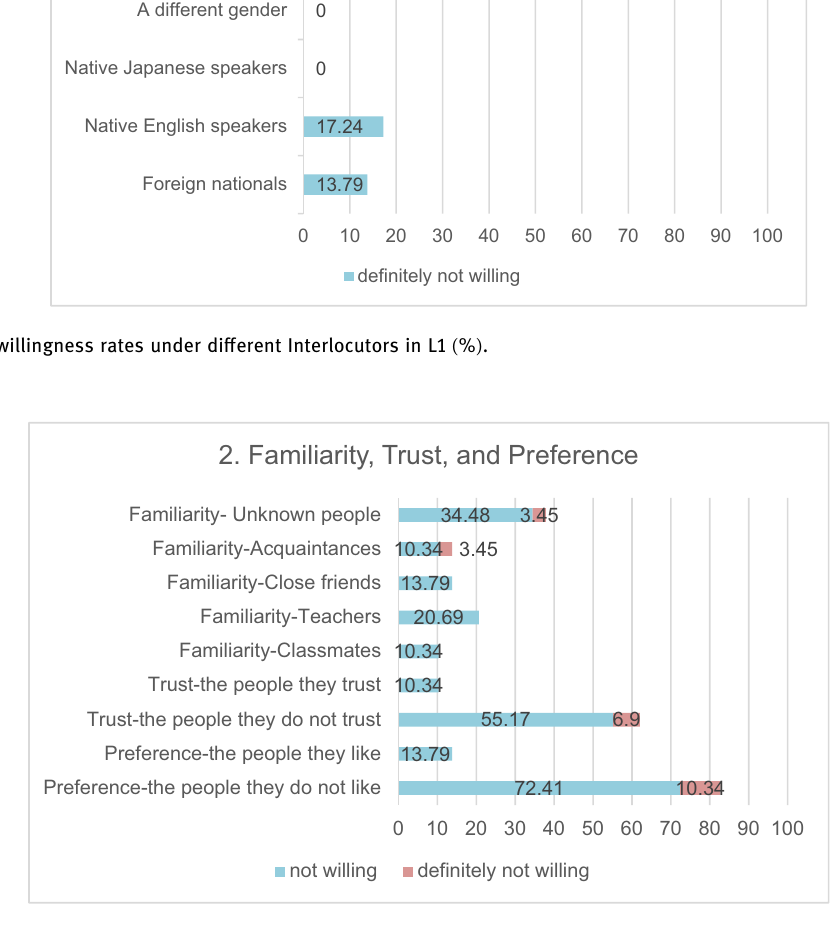
Figure 15: Unwillingness rates under di ff erent interlocutors in L2 ( % ) .